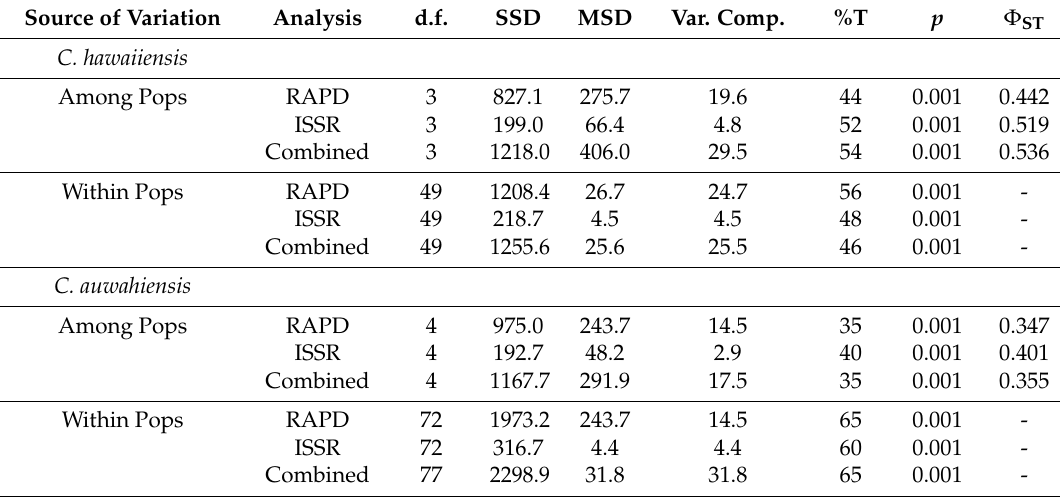
Table 3. Analysis of molecular variance (AMOVA) for 53 individuals in four populations of C. hawaiiensis and 77 individuals in five populations of C. auwahiensis based on combined RAPD, ISSR, and combined dataset analyses. Abbreviations: d.f., degrees of freedom; SSD, sum of squared deviation; MSD, mean squared deviation; Var. Comp., variance component; %T, percentage of total variance contributed by each component; p , probability of obtaining a more extreme component by chance alone; and Φ ST , the degree of differentiation between population